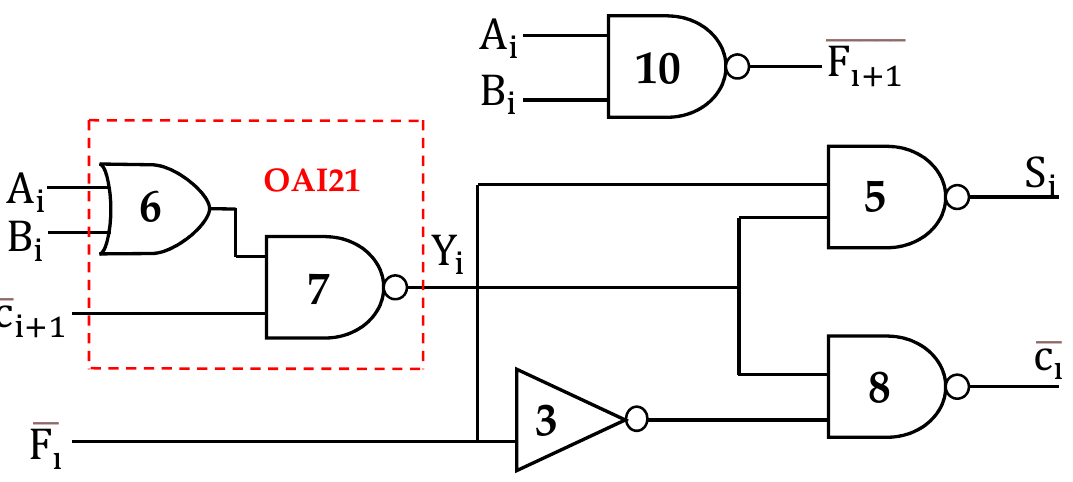
Figure 4. Schematic of RCPFA circuit design.